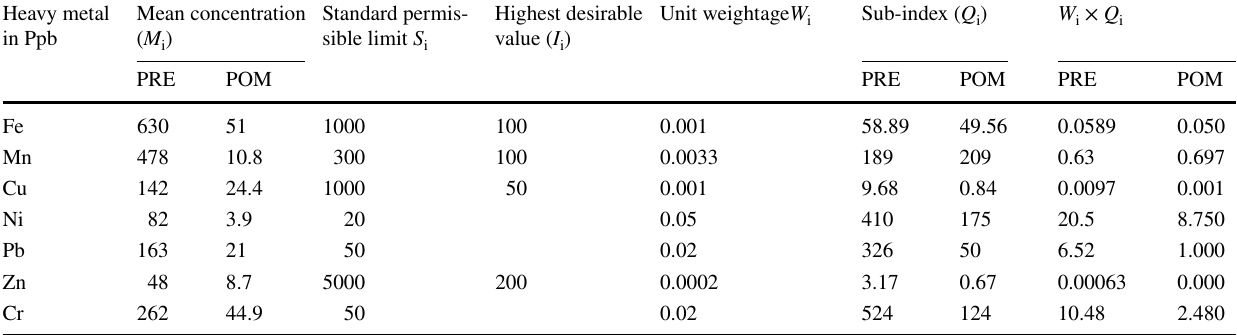
Table 5 Variables for calculating heavy metal pollution index for the mean concentration